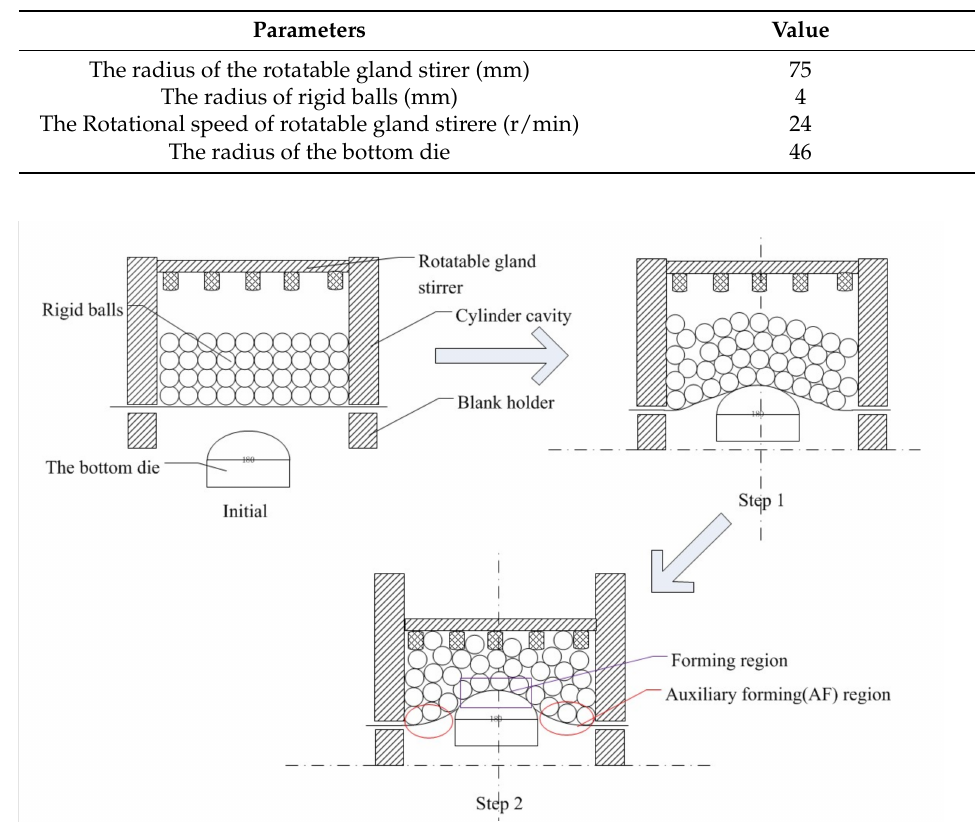
Table 2. Fundamental parameters for CBS forming.